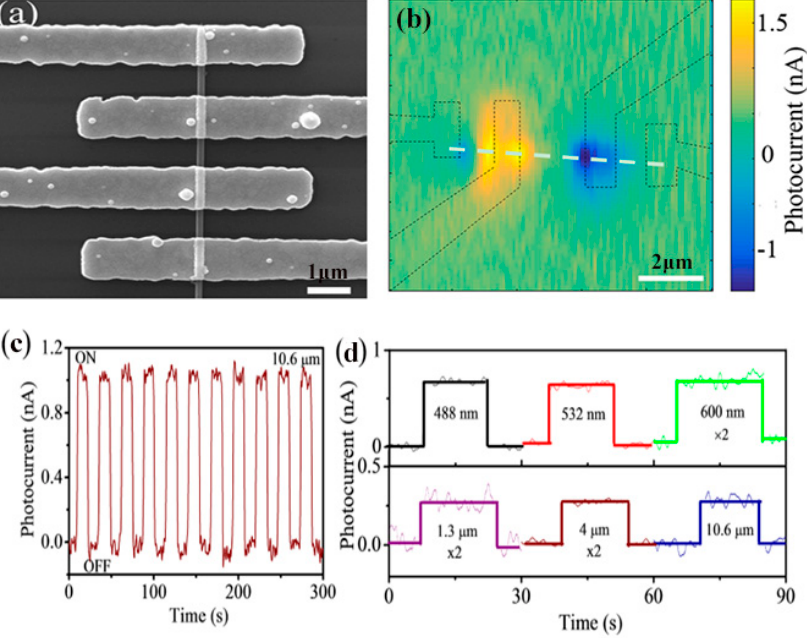
Figure 17. ( a , b ) SEM image and scanning photocurrent mapping of a single SmB 6 nanowire photodetector. ( c ) The time-dependent photocurrent measurement on the nanowire photodetector under 10.6- µ m irradiation. ( d ) Room temperature photoresponse of the SmB 6 device under photoexcitation with different excitation wavelengths (as marked) [91]. Copyright 2018, American Institute of